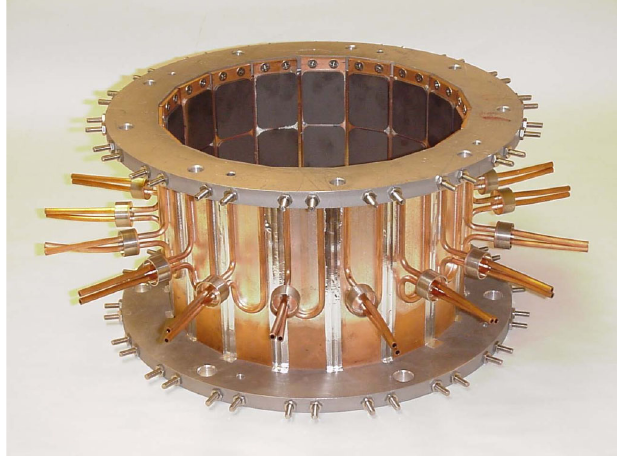
FIG. 24. Prototype HOM ferrite damper.